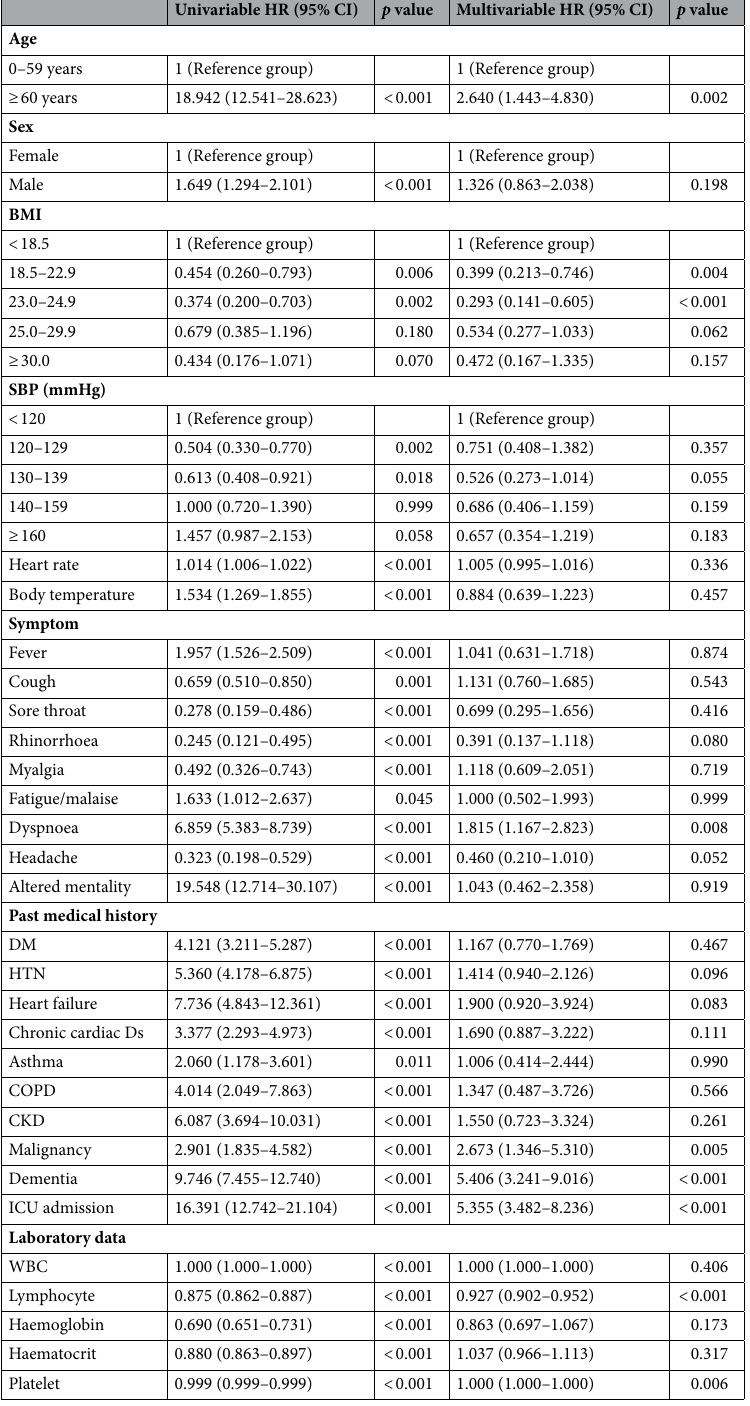
Table 5. Cox proportional hazards model for fatal adverse outcomes among COVID-19 patients. COVID-19 coronavirus disease 2019, HR hazard ratio, CI confidence interval, BMI body mass index, SBP systolic blood pressure, DM diabetes, HTN hypertension, Ds disease, COPD chronic obstructive pulmonary disease, CKD chronic kidney disease, ICU intensive care unit, WBC white blood